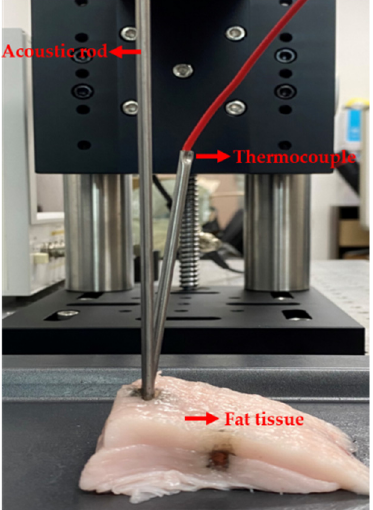
Figure 7. Experimental view for temperature tracking and TI.